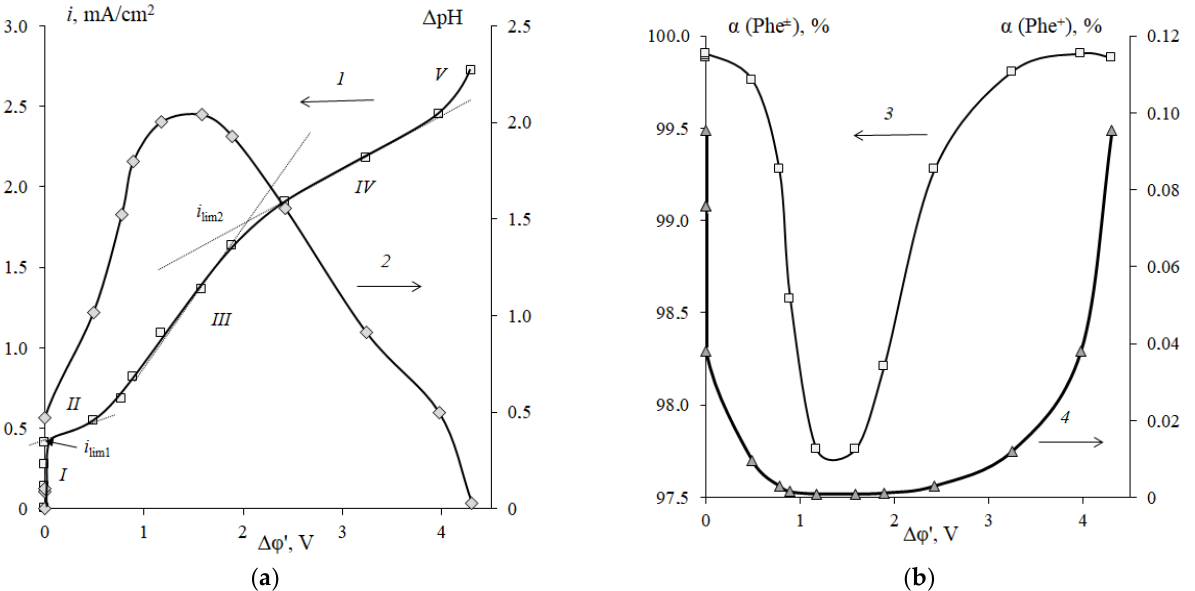
Figure 9. The CVC ( 1 ) and dependences of ΔpH ( 2 ) of the solution at the inlet and outlet of the demineralization compartment ( a ), the fraction of bipolar ions ( 3 ) and cations ( 4 ) of phenylalanine in the demineralized solution ( b ) on the corrected potential drop on the membrane (with resin content of 45 wt%) during electrodialysis of the mixed NaCl + Phe solution.